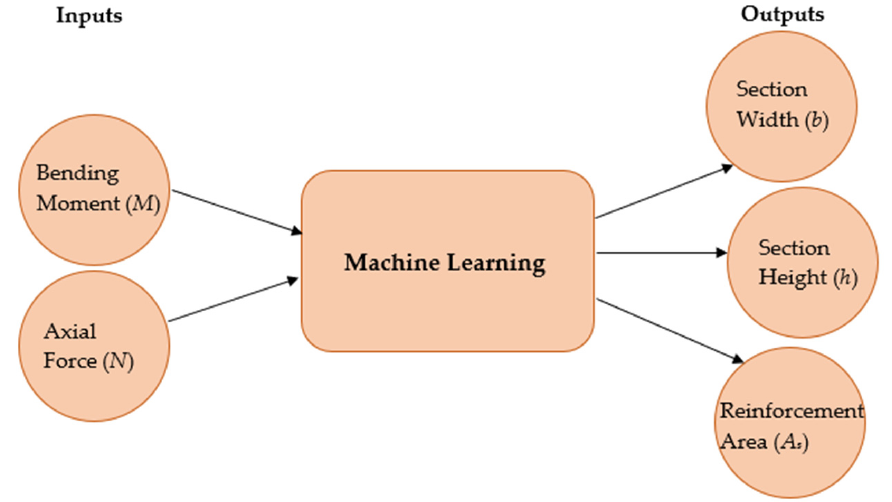
Figure 9. Inputs and outputs of the ML process.